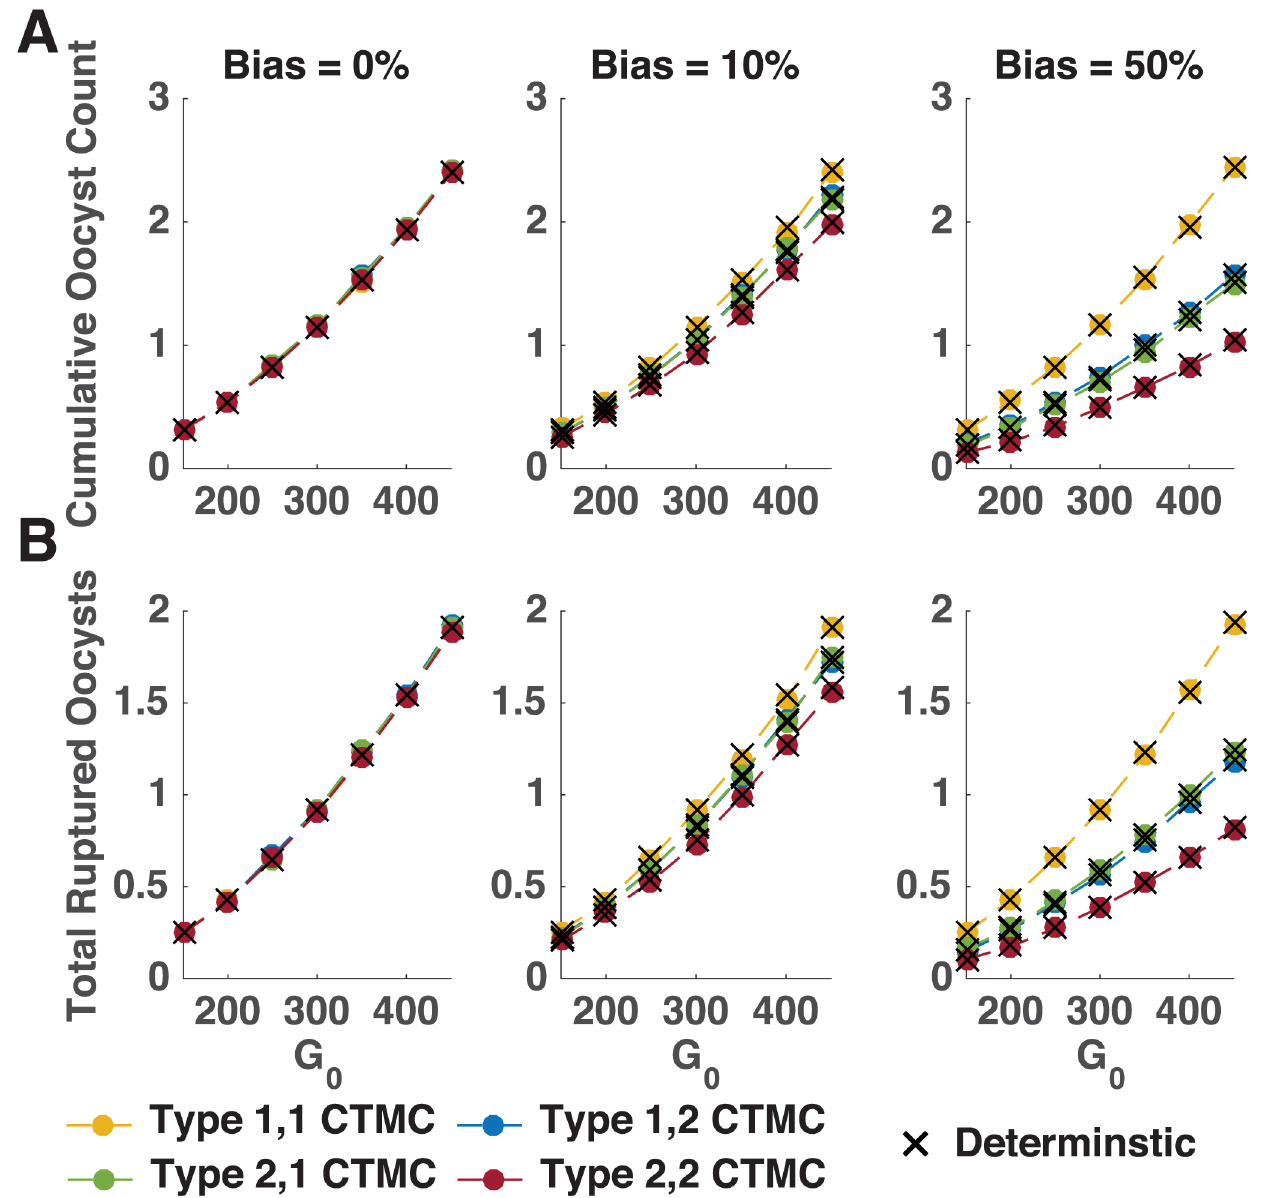
Fig 4. Cumulative and ruptured oocysts. The mean cumulativenumber (on day 21) of oocysts formed (A) and the total numberof ruptured oocysts (B) resultingfrom the 10,000 simulations of the two-parasite populationCTMC model (dots) and deterministic model (crosses) is illustrated for initial gametocyte number G 0 . Here, the CTMC model utilizes a more biologically realisticcontinuousrupture function for oocyst bursting, comparedto the step function used in the deterministic model. (See S4 Fig for the comparisonof models both using a step bursting function.) Left to right the columns illustrate the results for 0%, 10% and 50% fitness biases, respectively.